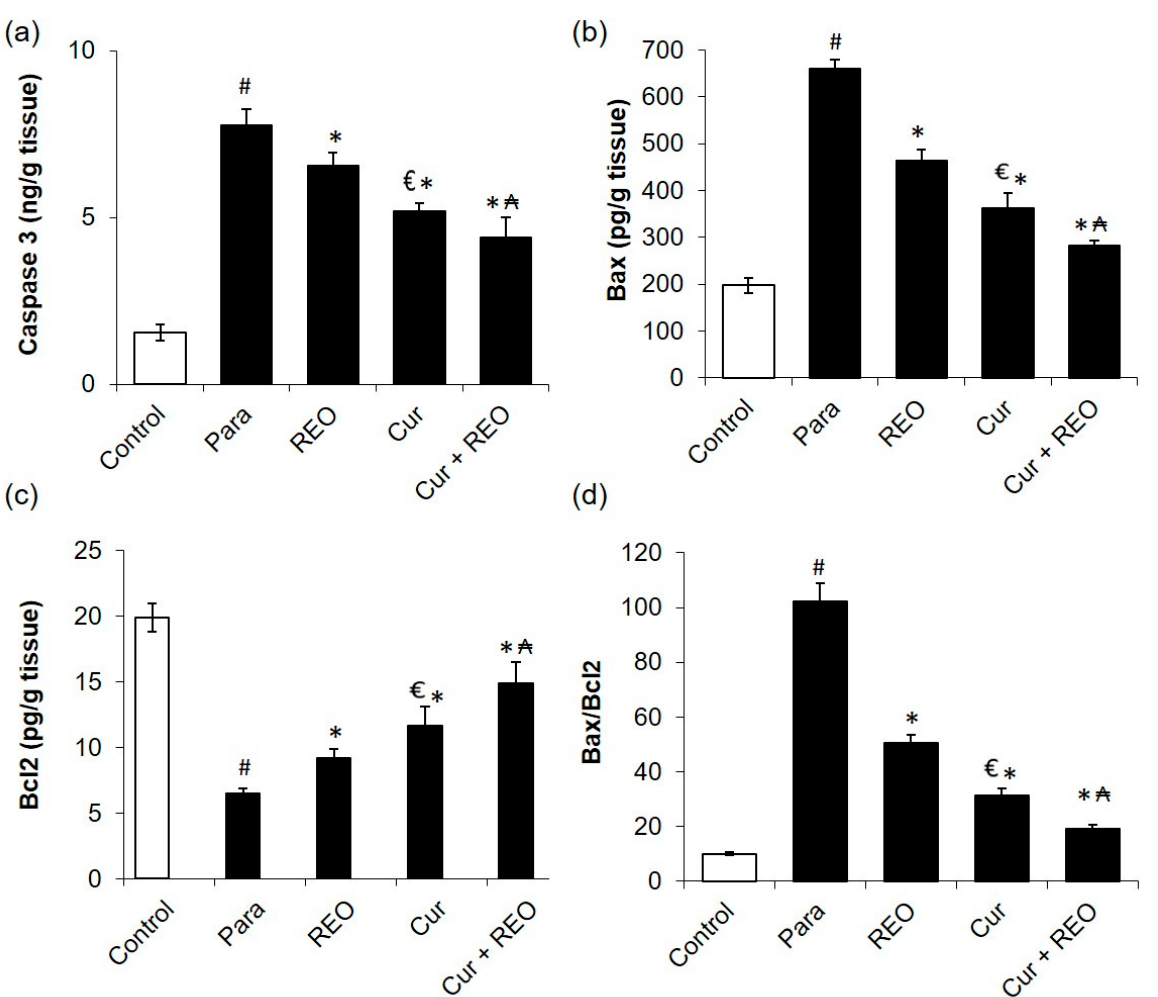
Figure 6. The effect of pretreatment with curcumin (Cur) and rosemary essential oil (REO) on hepatic homogenate of ( a ) caspase-3, ( b ) Bax, ( c ) Bcl2 and ( d ) Bax/Bcl2 ratio in paracetamol (Para) induced liver toxicity in mice. Each column represents the mean ± SD ( n = 6). The symbol # designates statistically significant compared to the control group, * defines statistically significant compared to the Para group ( p < 0.05), € describes statistically significant compared to the REO group ( p < 0.05), and ₳ designates statistically significant compared to the Cur and REO groups ( p < 0.05) using one-way ANOVA followed by Tukey’s post hoc